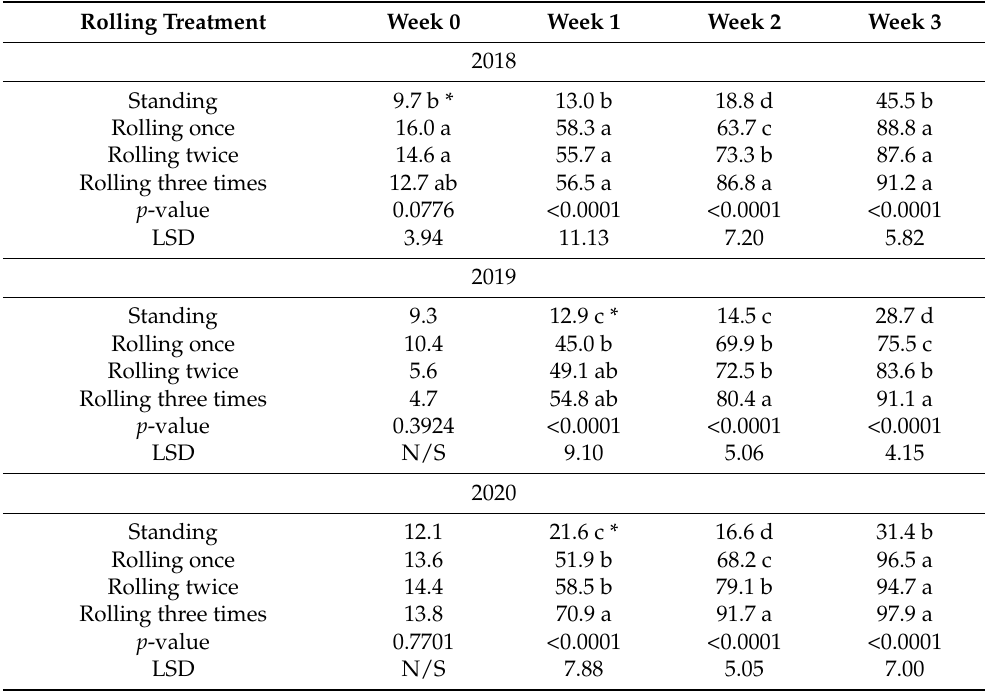
Table 6. Cover crop termination results (%) during 2018, 2019, 2020 growing seasons for cereal rye/crimson clover